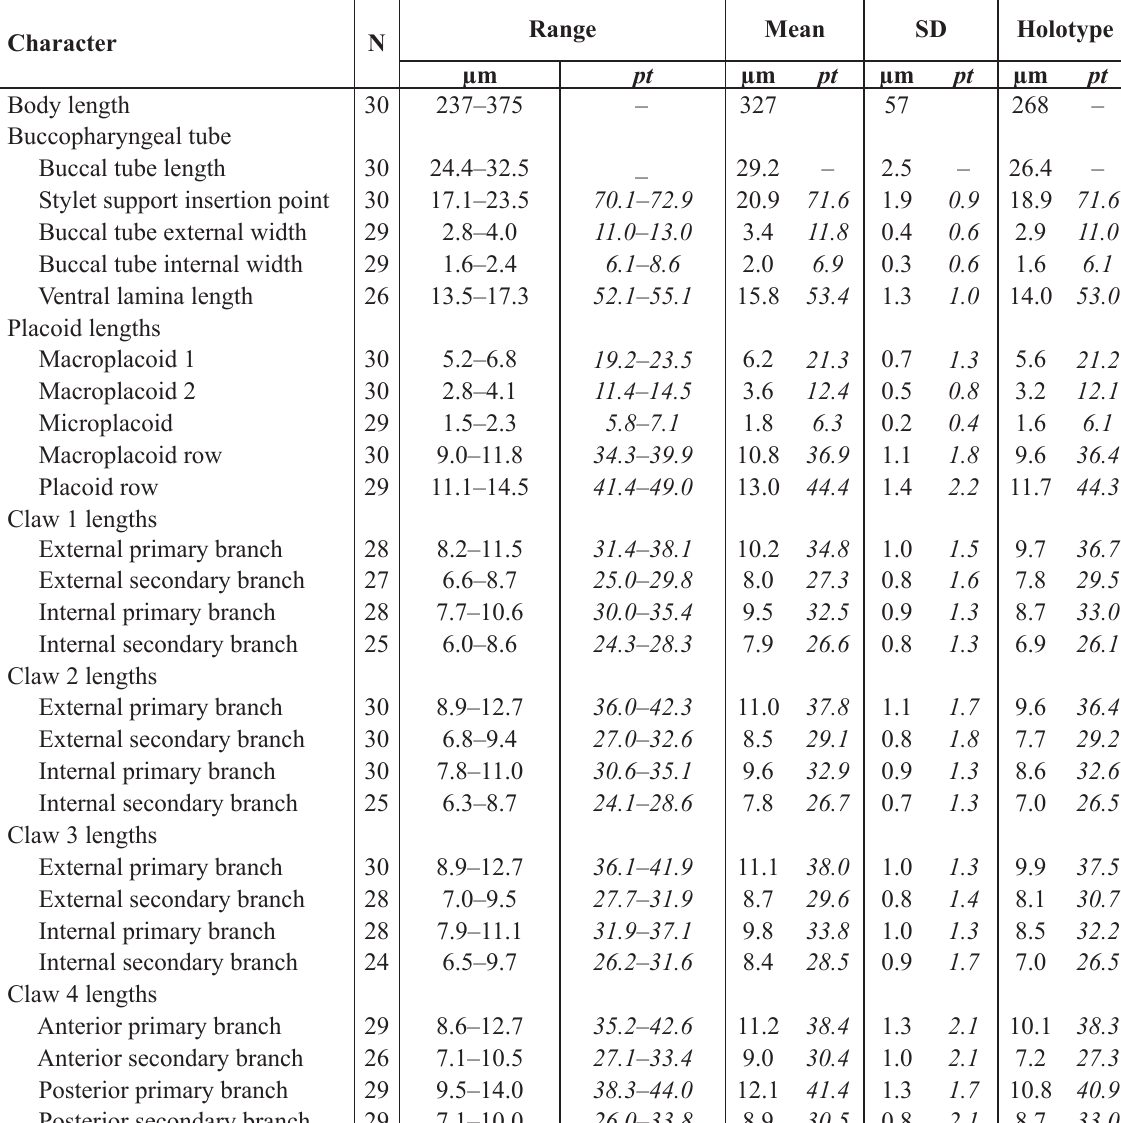
Table 3. Measurements (in µm) of selected morphological structures of individuals of Macrobiotus polypiformis sp. nov. mounted in Hoyer’s medium (N = number of specimens/structures measured; Range = the smallest and the largest structure among all measured specimens; SD = standard